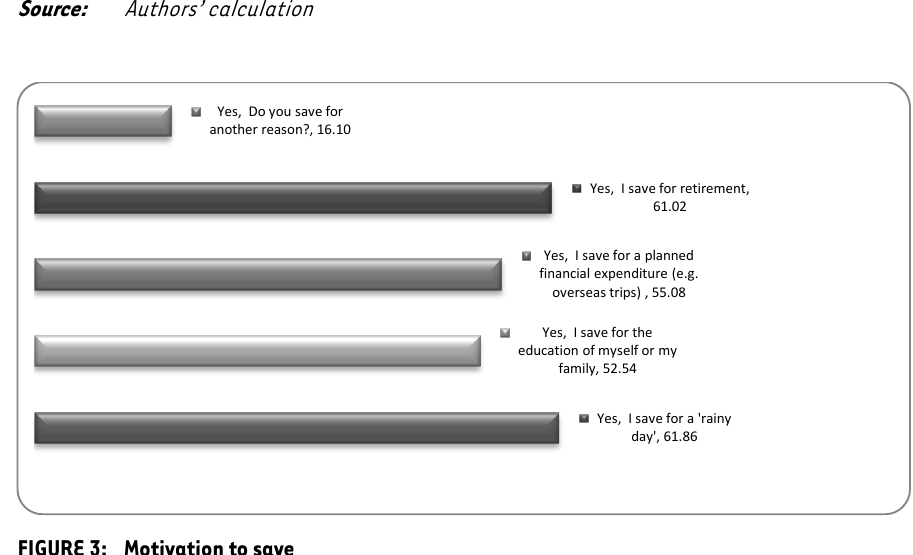
FIGURE 3: Motivation to save Source: Authors’